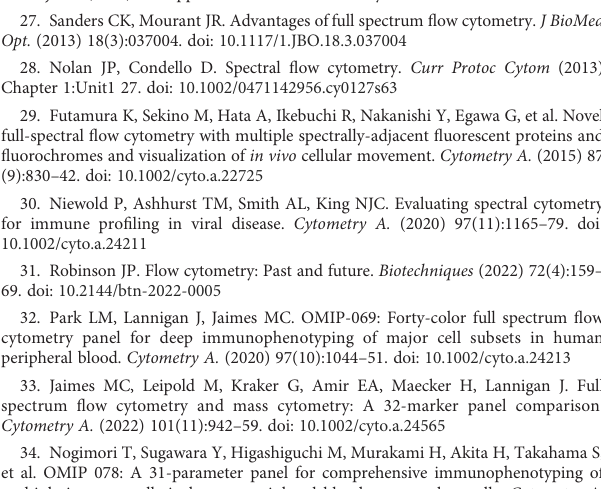
SUPPLEMENTARY FIGURE 5 Immunophenotyping of RA patients. (A) Summary heatmap depicting the marker expression as median fl uorescent intensity (MFI) in the indicated (A) PBMC and (B) T cell subsets of 5 pooled RA patients and 5 pooled HCs, respectively. Each column represents the indicated subsets in either HCs or RA patients, each row depicts the marker expression. For the expression values of every marker - cell type combination a min-max normalization was applied. Heatmaps were generated in R using the “ Complex Heatmap ” package, k-means clustering was applied imposing (A) 4 clusters and (B) 5 clusters, respectively; data were scaled by row and clustered by rows. (C) Loadings plot for the corresponding PCA in depicting the individual component loadings of the marker – cell type combinations in PC1, PC2 and PC3. (A – C) The DC subset encompasses pDCs and mDCs. Abbreviations are used as follows: Principal Component Analysis (PCA), principal component (PC), healthy control (HC), rheumatoid arthritis (RA), dendritic cells (DC), monocytes (Mo), natural killer cells (NKs), B cells (Bc), T cells (Tc), T helper cells (Th), regulatory T cells (Treg), T follicular helper cells (Tfh), T peripheral helper cells